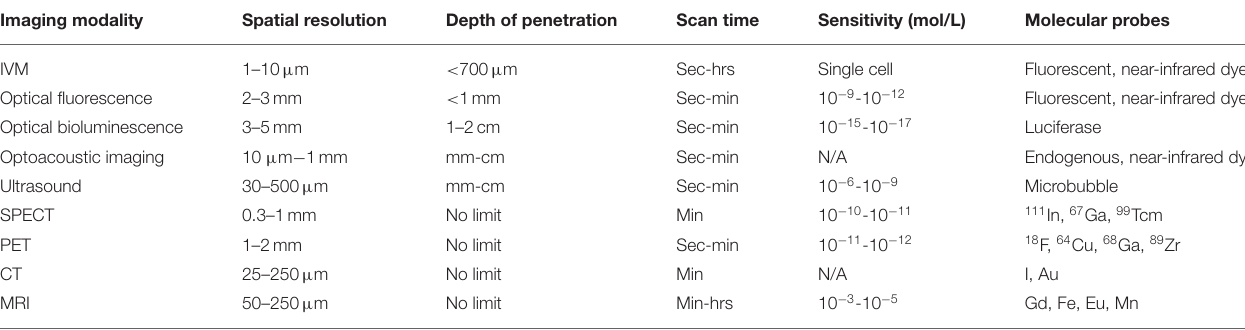
TABLE 1 | Multi-scale imaging modalities and their technical specifications. Imaging